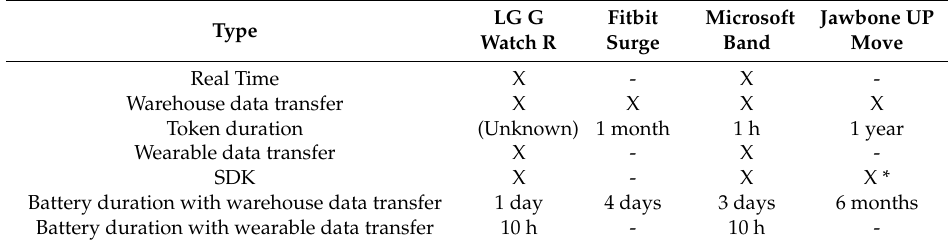
Table 5. Features related to the transfer of data from the